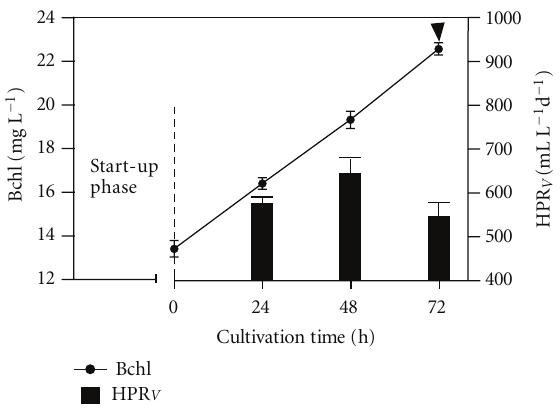
Figure 5: Changes in the Bchl concentration versus the cultivation time and relative HPR V achieved in time, under SCR, at 30 ◦ C with an irradiance of 480 Wm − 2 . The HRT was 225 hours. The arrow indicates the cultivation time when we withdrew 80mL of culture volume from the reactor and replaced with an equal volume of fresh medium.